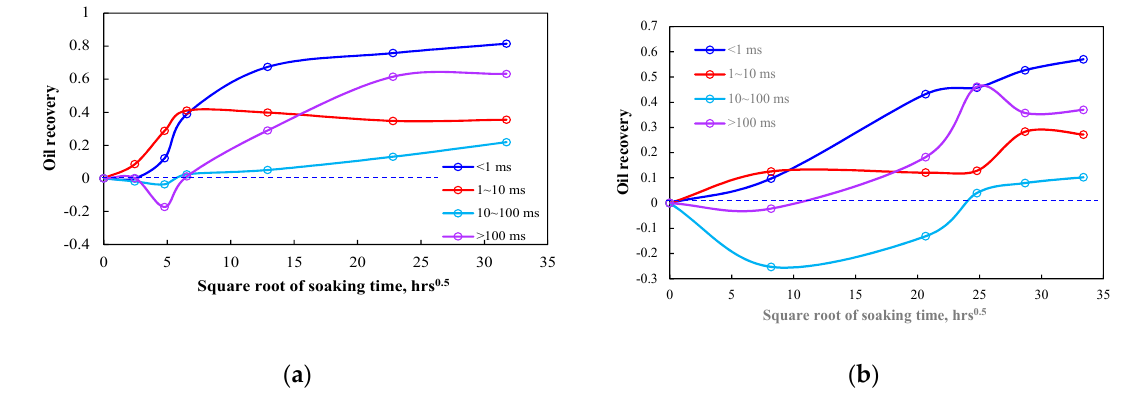
Figure 14. Oil recovery in different diameter pores: ( a ) QT-1 and ( b ) QT-2.